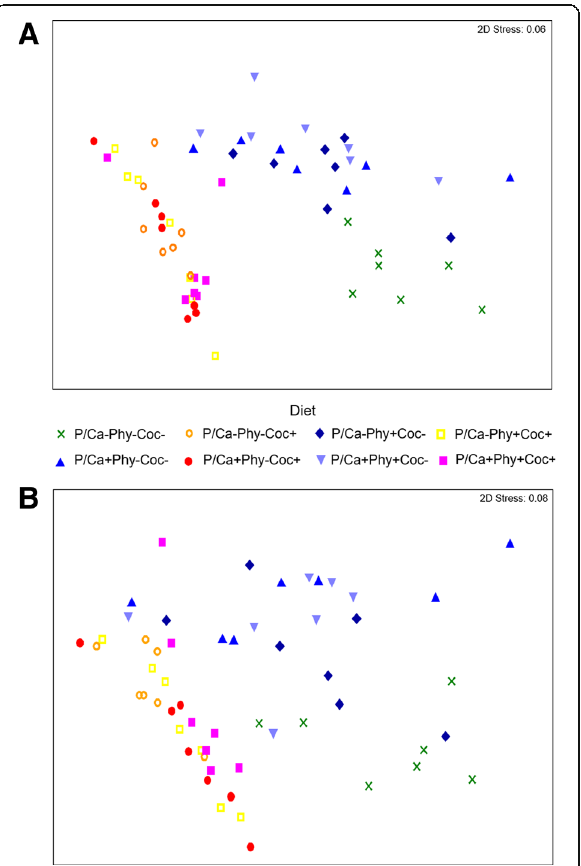
Fig. 1 Non-metric multi-dimensional scaling plot. The global bacterial community structure of dietary treatments in the digesta samples of crop ( a ) and ileum ( b ). The symbols represent one pooled sample from each pen comprising all Operational Taxonomic Units